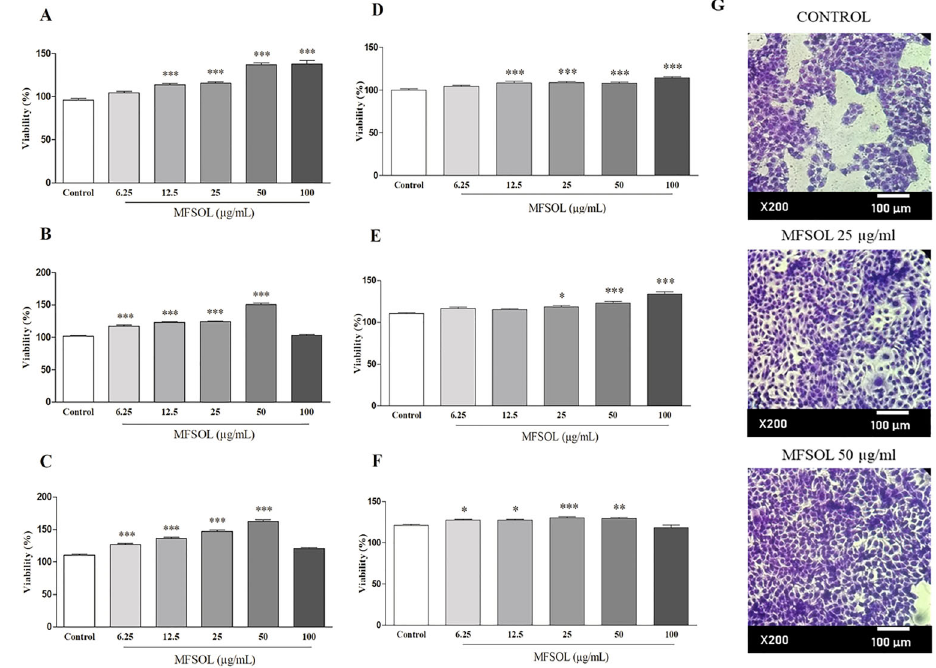
Figure 2. Effect of methanol fraction of Sideroxylon obtusifolium (MFSOL) on cell viability of human keratinocytes (HaCaT). Increased viability of keratinocytes was produced by MFSOL (6.25 – 100 m g/mL) after 24 ( A ), 48 ( B ), and 72 ( C ) h of incubation by the MTTassay and SRB assay ( D , E , and F ), respectively. To illustrate the HaCaT density, photographs were taken at 200 (cid:1) magni fi cation (scale bar 100 m m) 48 h after treatment with 25 and 50 m g/mL of MFSOL ( G ). Data are reported as means ± SE of at least three independent experiments. *P o 0.05, **P o 0.01, ***P o 0.001, compared to the Control (Vehicle) group (one-way ANOVA followed by the Tukey